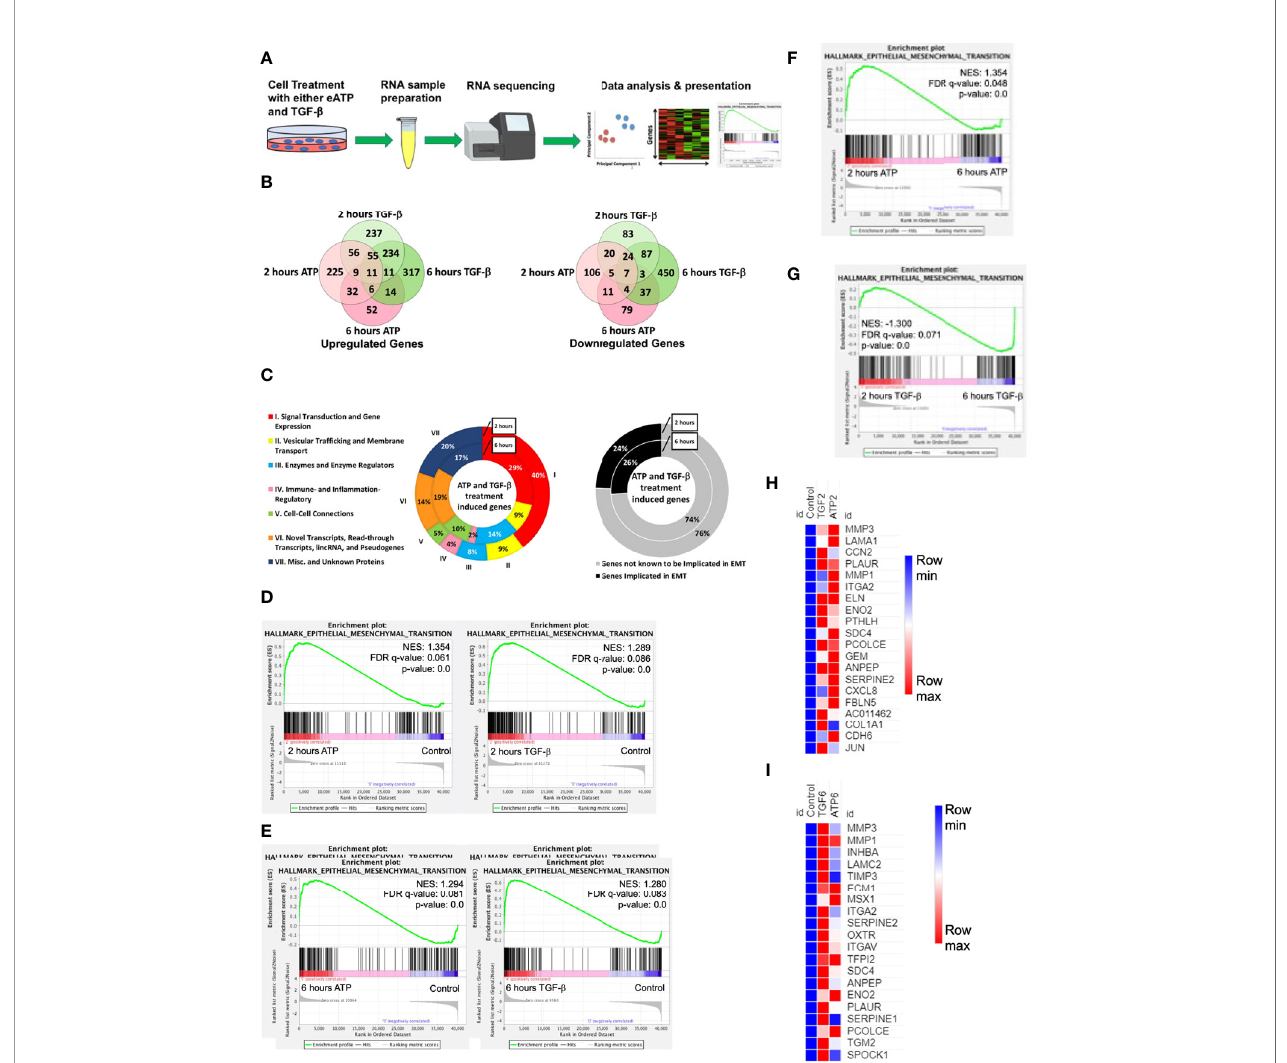
FIGURE 1 | RNAseq study. A549 cells were treated with either 0.5 mM ATP or 10 ng/mL TGF- b for 2 or 6 hours with three replicates per treatment condition. After the treatment, polyA-containing RNA was isolated and then sent to a commercial service company for RNAseq analysis as described in detail in the Materials and Methods. The general RNAseq results are presented in Venn diagrams, pie graphs, GSEA plots, and heatmaps. NES: normalized enrichment score. (A) Work fl ow for RNA-sequencing study. (B) Venn Diagram of genes signi fi cantly upregulated (left) or downregulated (right) by either ATP or TGF- b at 2 or 6 hours. (C) pie graph that shows the 131 EMT related genes upregulated by both eATP and TGF- b at 2 hours and 42 genes at 6 hours (left), and percentage of known EMT genes at both times (right). (D) Gene set enrichment analysis (GSEA) plots for the “ Hallmark - Epithelial mesenchymal transition ” signature, 2 hours ATP compared to control (left) and 2 hours TGF- b compared to control (right). ( E – G): GSEA plots for the “ Hallmark - Epithelial mesenchymal transition ” signature. (E) 6 hours ATP compared to control (left) and 6 hours TGF- b compared to control (right). (F) 2 hours ATP compared to 6 hours ATP. (G) 2 hours TGF- b compared to 6 hours TGF- b . ( H, I): Heatmap showing top 20 enriched genes from the ” Hallmark - Epithelial mesenchymal transition ” signature in (H) 2 hours ATP and 2 hours TGF- b and (I) 6 hours ATP and 6 hours TGF- b . For heatmaps (H) and (I) , FPKM values for all three replicates of each gene are shown in the Supplemental Tables 2 , 3